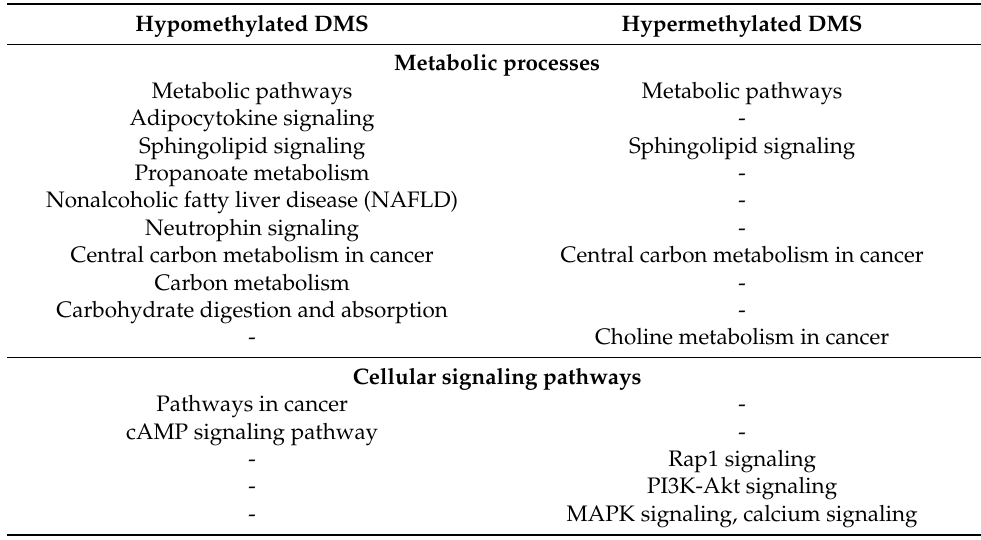
Table 5. The list of molecular and biochemical pathways relevant for DMS-associated genes, sepa- rated for hypomethylated and hypermethylated